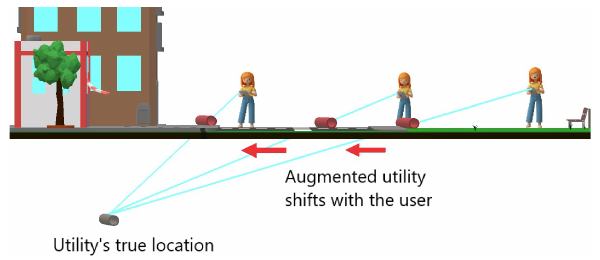
Figure 3. Parallax effect of virtual pipe with the user movement.